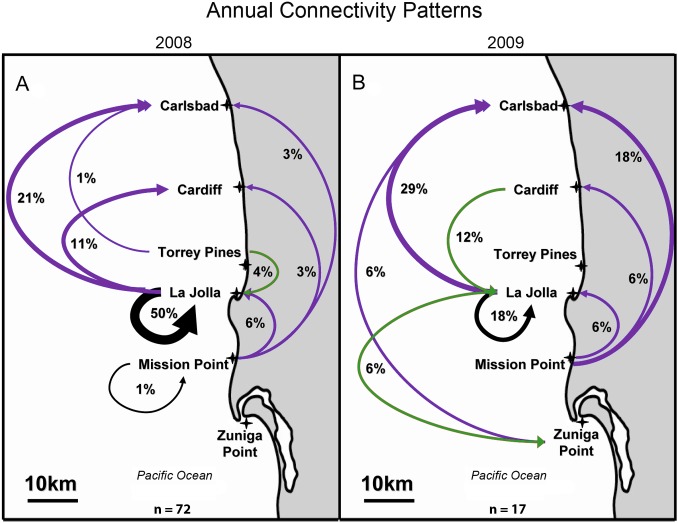
Aggregate annual connectivity patterns in 2008 (Fig. 2A) and 2009 (Fig. 2B).Grey region is land and white region is ocean. Arrows indicate predicted larval dispersal trajectories from natal origin to capture location of post-settlement YOY. Purple arrows indicate northward dispersal, green arrows indicate southward dispersal, and black arrows indicate self-recruitment. Thickness of arrows is proportional to the number of individuals dispersing among reefs. Annual sample sizes of YOY (n) are provided at the bottom of each sub-panel (e.g. the natal origins of 72 post-settlement YOY were determined in 2008). Percentages in each sub-panel indicate the proportion of YOY dispersing within the entire study system. For example, in 2008, 36 of 72 (i.e. 50%) of YOY collected at La Jolla appear to have self-recruited. Crosses indicate location of primary study sites.